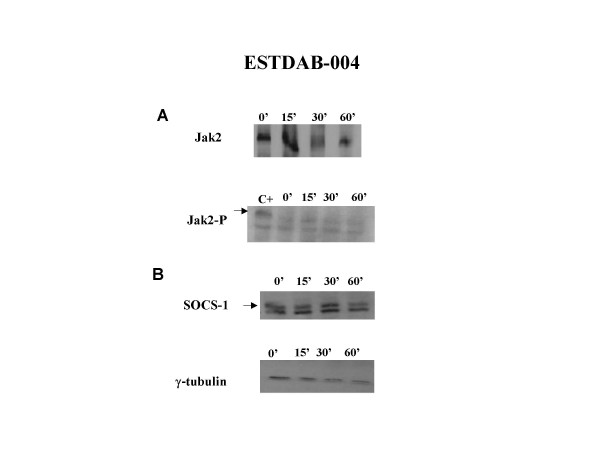
Western blot analysis of the expression level and phosphorylation status of Jak-2 (A), and of the expression of SOCS-1 (B) in ESTDAB-004 cell line. We observed that Jak-2 was present but its phosphorylation was very low and was accompanied by a high SOCS-1 expression (negative regulator of IFN-γ response). Arrows indicate the specific proteins. Nuclear extracts as a positive control (C+) for Jak-2 were obtained from Cell Signaling.